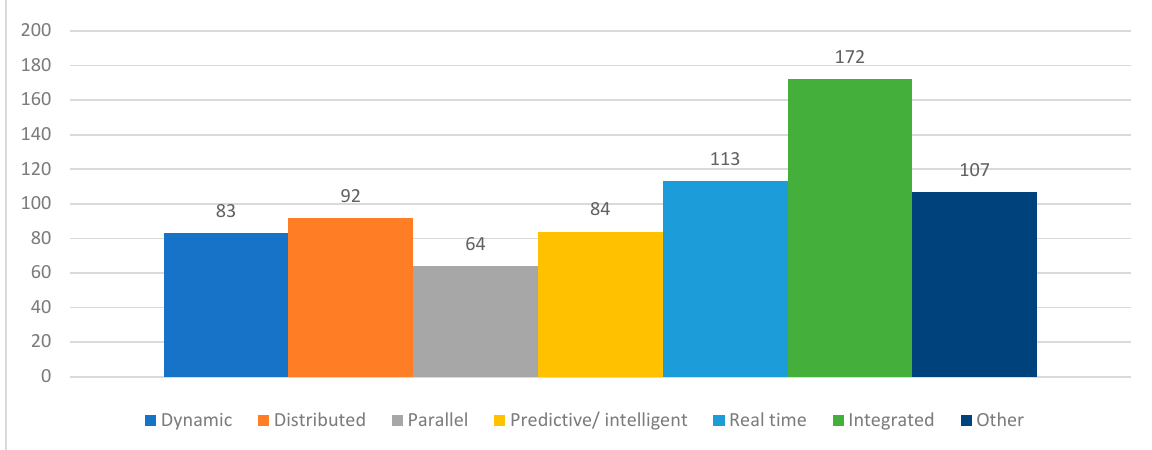
Figure 3. Progression of the number of publications about manufacturing management paradigms from 2011 to 2021.